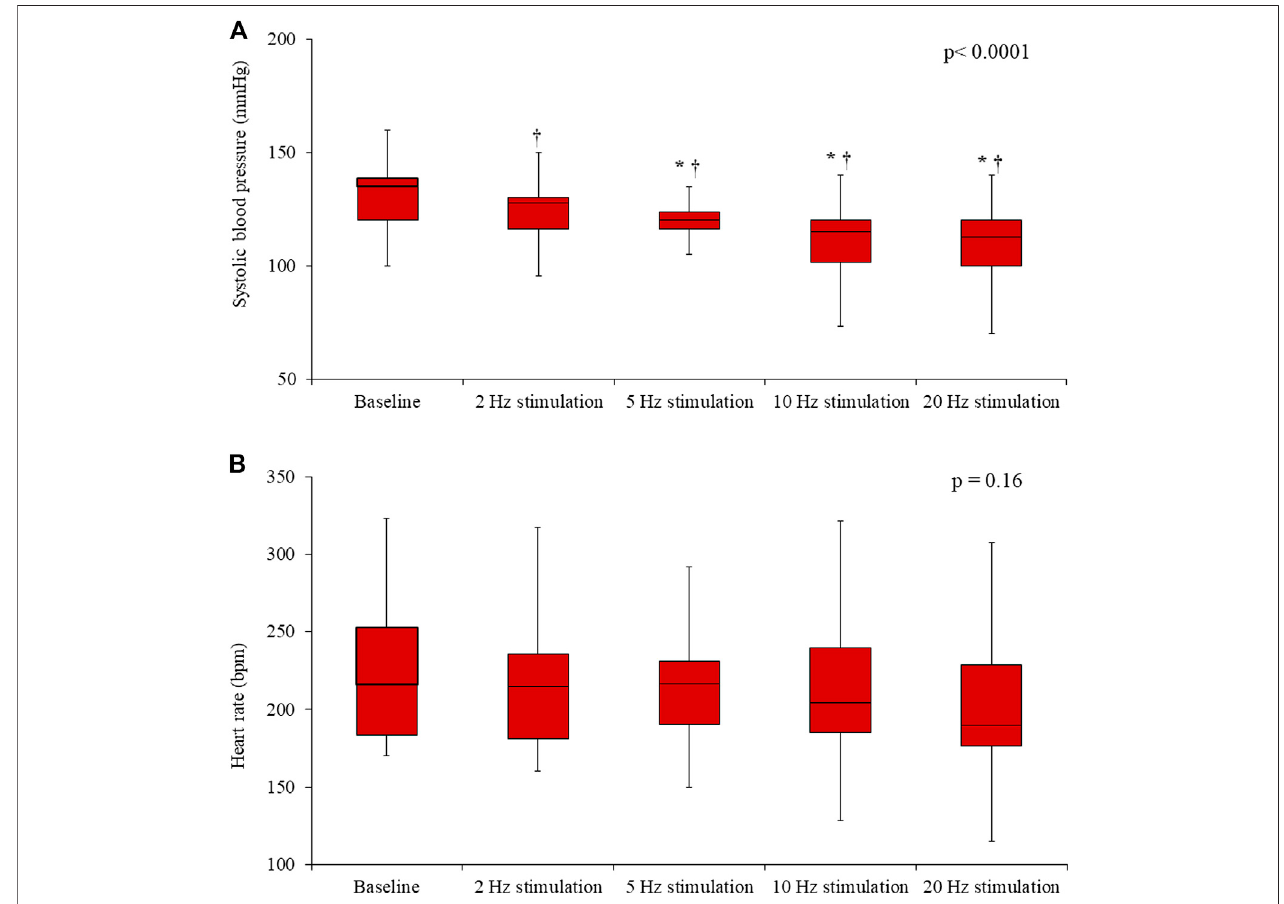
FIGURE 5 | Systolic blood pressure (A) and heart rate (B) values prior to (baseline) and during vagus nerve stimulation at 2, 5, 10, and 20 Hz in the ivabradine- treated rats ( n (cid:2) 10). Data are expressed as median and interquartile range (IQR). The ends of the whiskers represent the lowest value within 1.5 IQR of the fi rst quartile and the highest value within 1.5 IQR of the third quartile. p -values in the right upper corners were obtained using nonparametric repeated-measures ANOVA (Friedman test). * p < 0.05 vs. the value obtained during the previous stimulation using the paired Student ’ s t -test or the Wilcoxon matched-pairs signed-rank test, as appropriate; † p < 0.05 vs. baseline using the paired Student ’ s t -test or the Wilcoxon matched-pairs signed-rank test, as